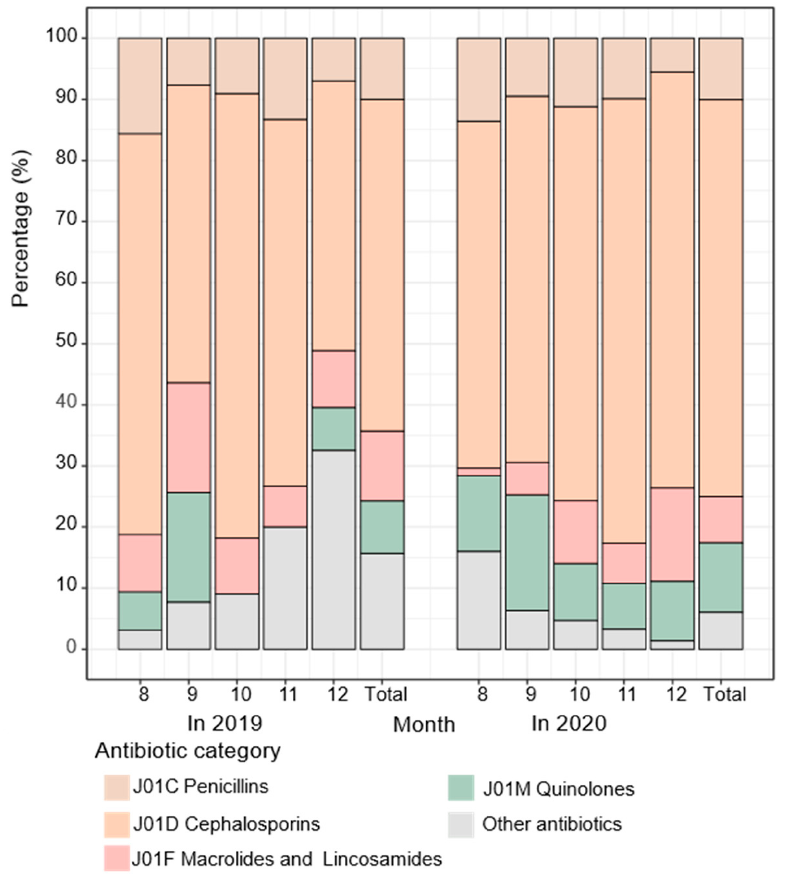
Figure 1. The proportion of different categories of antibiotics in medicine diaries among the study population in Eastern China, 2019–2020. (Data shown are unstandardized percentages. The proportion of cephalosporins are different between 2019 and 2020 ( p = 0.011).).